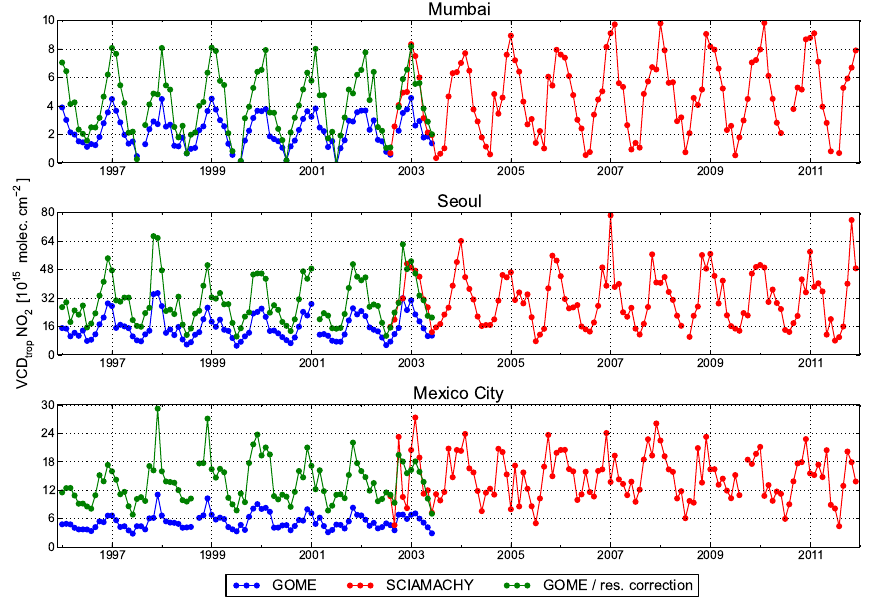
Fig. 11. Time series of original GOME (blue), resolution-corrected GOME (green), and SCIAMACHY (red) measurements of tropospheric NO 2 for the three selected megacities Mumbai, Seoul, and Mexico City.